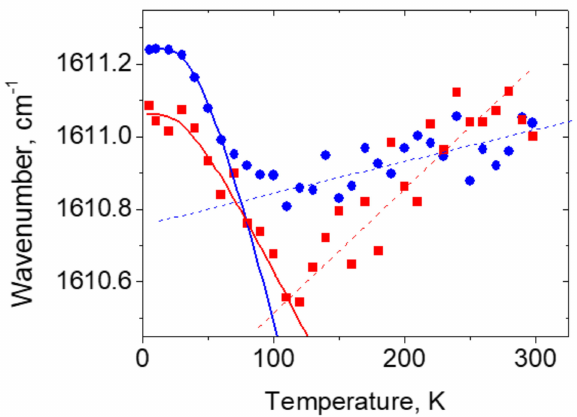
Figure 32. Temperature dependence of the C = O vibrational wavenumber of TPA(H) (circles) and TPA(D) (squares) carboxylic groups. Solid curves show temperature dependences of the thermal population of phonons ω A (see the text); the dependences above 100 K are imaged by dashed lines, which are drawn